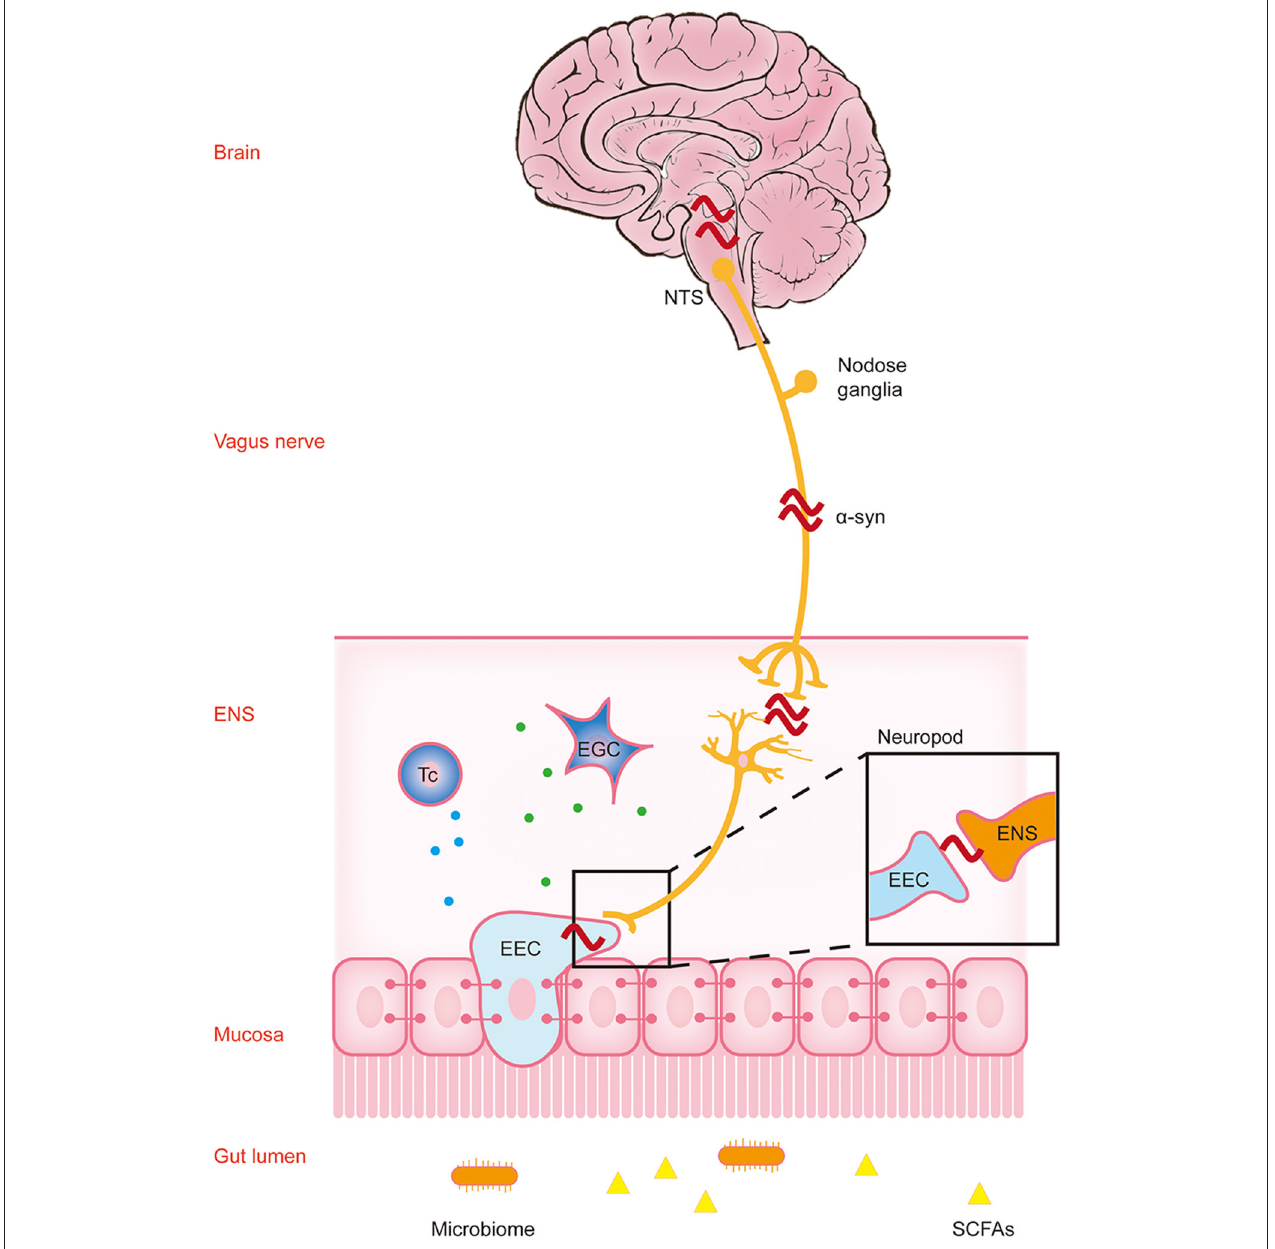
FIGURE 1 | Parkinson’s disease pathology spreads along the brain-gut axis through the vagus nerve. This figure reflects the “gut-first” hypothesis as well as the “brain-first” hypothesis was omitted. The environmental changes in the intestinal lumen may pass through the gastrointestinal wall and enter the myenteric neurons, triggering the formation of α -synuclein inclusions in the enteric nervous system (ENS). Parkinson’s disease (PD) pathology was first found in the ENS, and this process may cause gastrointestinal dysfunction in the early stage of PD. The change in the lumen environment may lead to pathological changes in α -synuclein in enteric endocrine cells (EEC). Through the structure named “neuropods,” this signal is transmitted to the ENS, and induces the pathological changes in α -synuclein in the ENS. A variety of immune cells in the lamina propria may participate in this process through a variety of immune responses. Subsequently, α -synuclein ascends retrograde through the vagus nerve to the neurons in the dorsal motor nucleus of the vagus (DMV) in the brainstem, and finally reaches the substantia nigra pars compacta (SNpc), causing dopaminergic neuronal degeneration. At this time patients show typical motor symptoms of PD. NTS, nucleus tractus solitarius; α -syn, α -synuclein; Tc, T cells; EGC, enteric glial